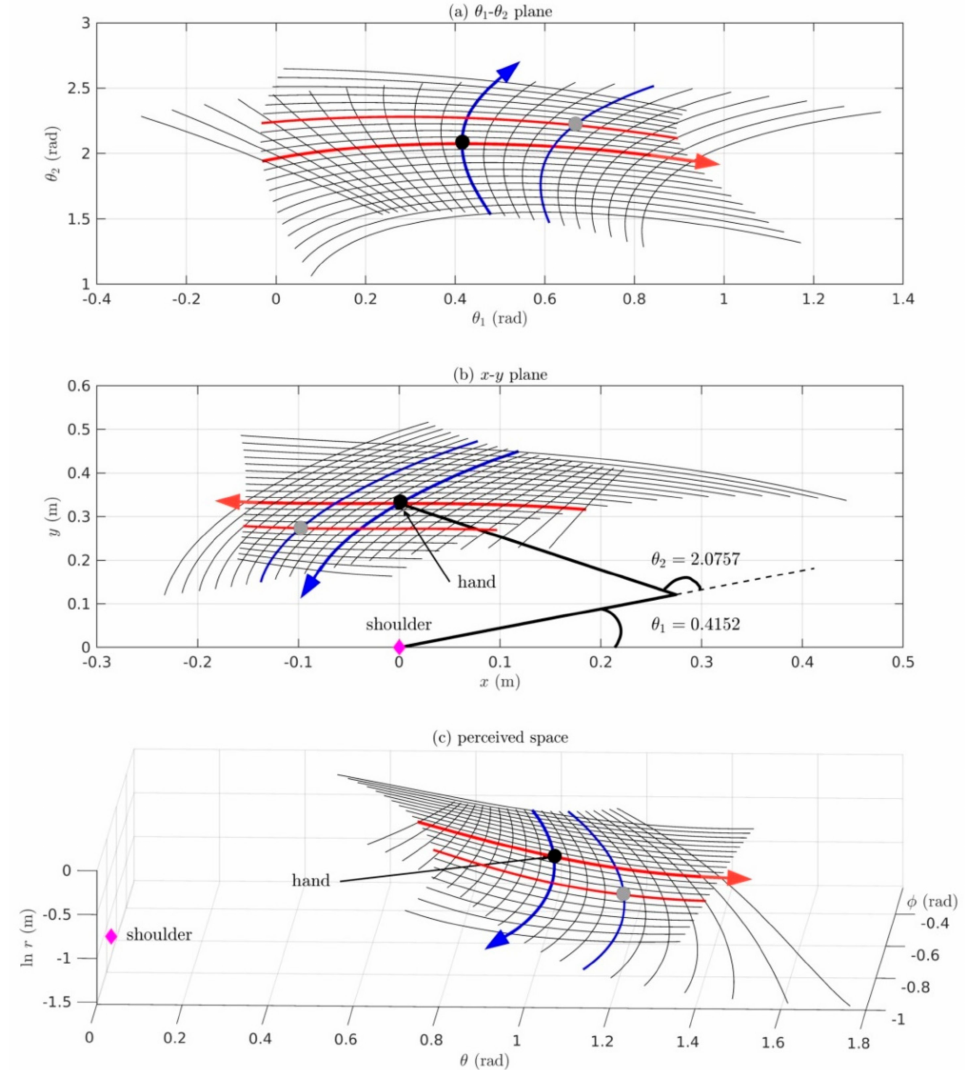
Figure 4. Results of MATLAB/Simulink simulation of a two-DOF arm moving in the horizontal plane through the shoulder depicting the transformation of geodesic trajectories in the 2D curved proprioceptive joint-angle space into the 3D curved visual space ( G , g ) . ( a ) shows a totally geodesic grid in joint-angle space ( θ 1 – θ 2 ) of the two-DOF arm moving along natural free-motion geodesic trajectories in the horizontal plane attributable to its mass-inertia characteristics. ( b ) shows the corresponding ( x-y )-positions of the hand in the Euclidean ( x-y ) horizontal plane for corresponding points along the geodesic grid lines in ( a ). These were computed trigonometrically using Equation (4). The line drawing in Figure ( b ) illustrates the θ 1 and θ 2 angles of the arm when the hand is located at the centre of the grid. ( c ) shows the corresponding grid of visually-perceived positions of the hand in the 3D warped visual space ( G , g ) spanned by the cyclopean coordinates ( ln r , θ , ϕ ) as described in the text. Equivalent example trajectories in ( a – c ) are indicated by lines of similar colour and thickness. Arrows on these lines indicate the directions in which joint angles θ 1 and θ 2 are